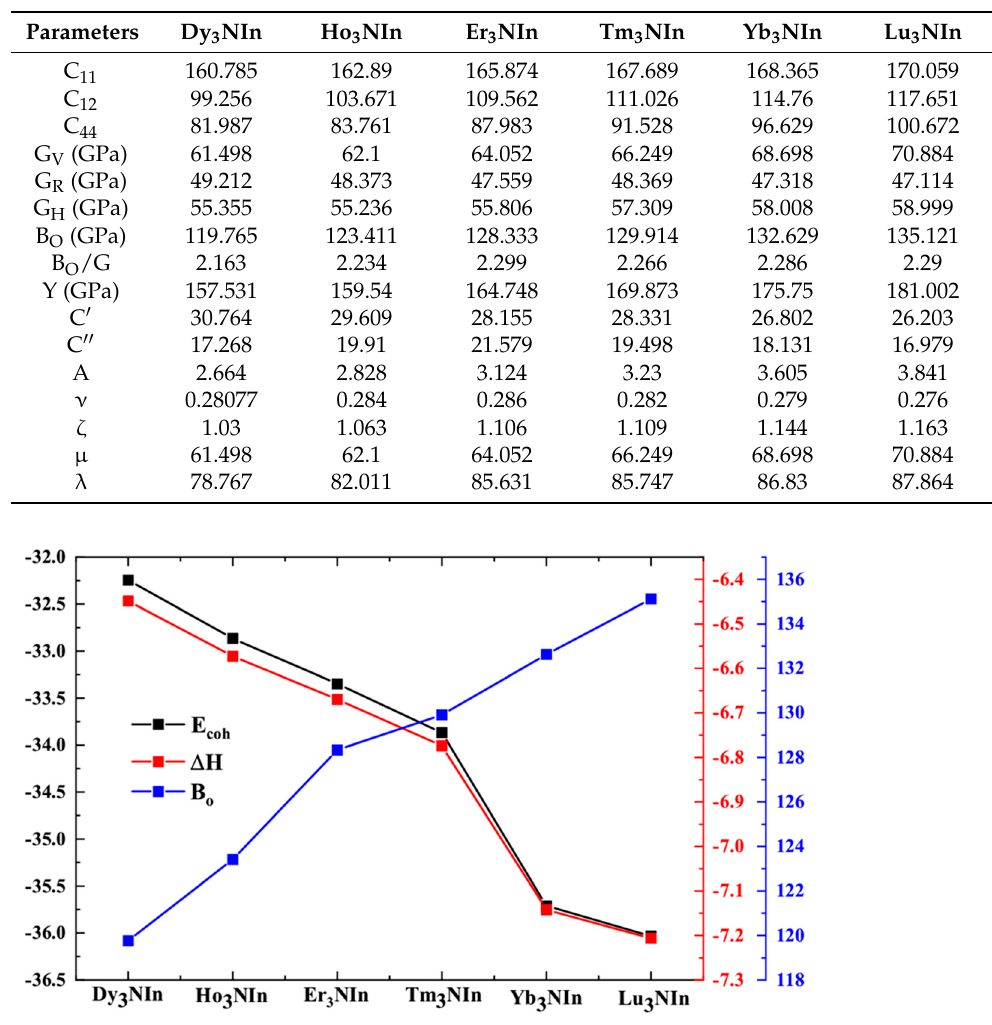
Table 2. Estimated elastic moduli C ij , Voigt’s (G v ) shear modulus, Reuss’s(G R ) shear modulus, Hill’s shear modulus (G H ), Bulk modulus (B O ),Pugh-ratio(B O /G),Young modulus (Y), shear constant (C (cid:48) ), Cauchy-Pressure (C”),Anisotropy constant (A), Poisson’s ratio ( υ ), Kleinman parameter ( ζ ) and